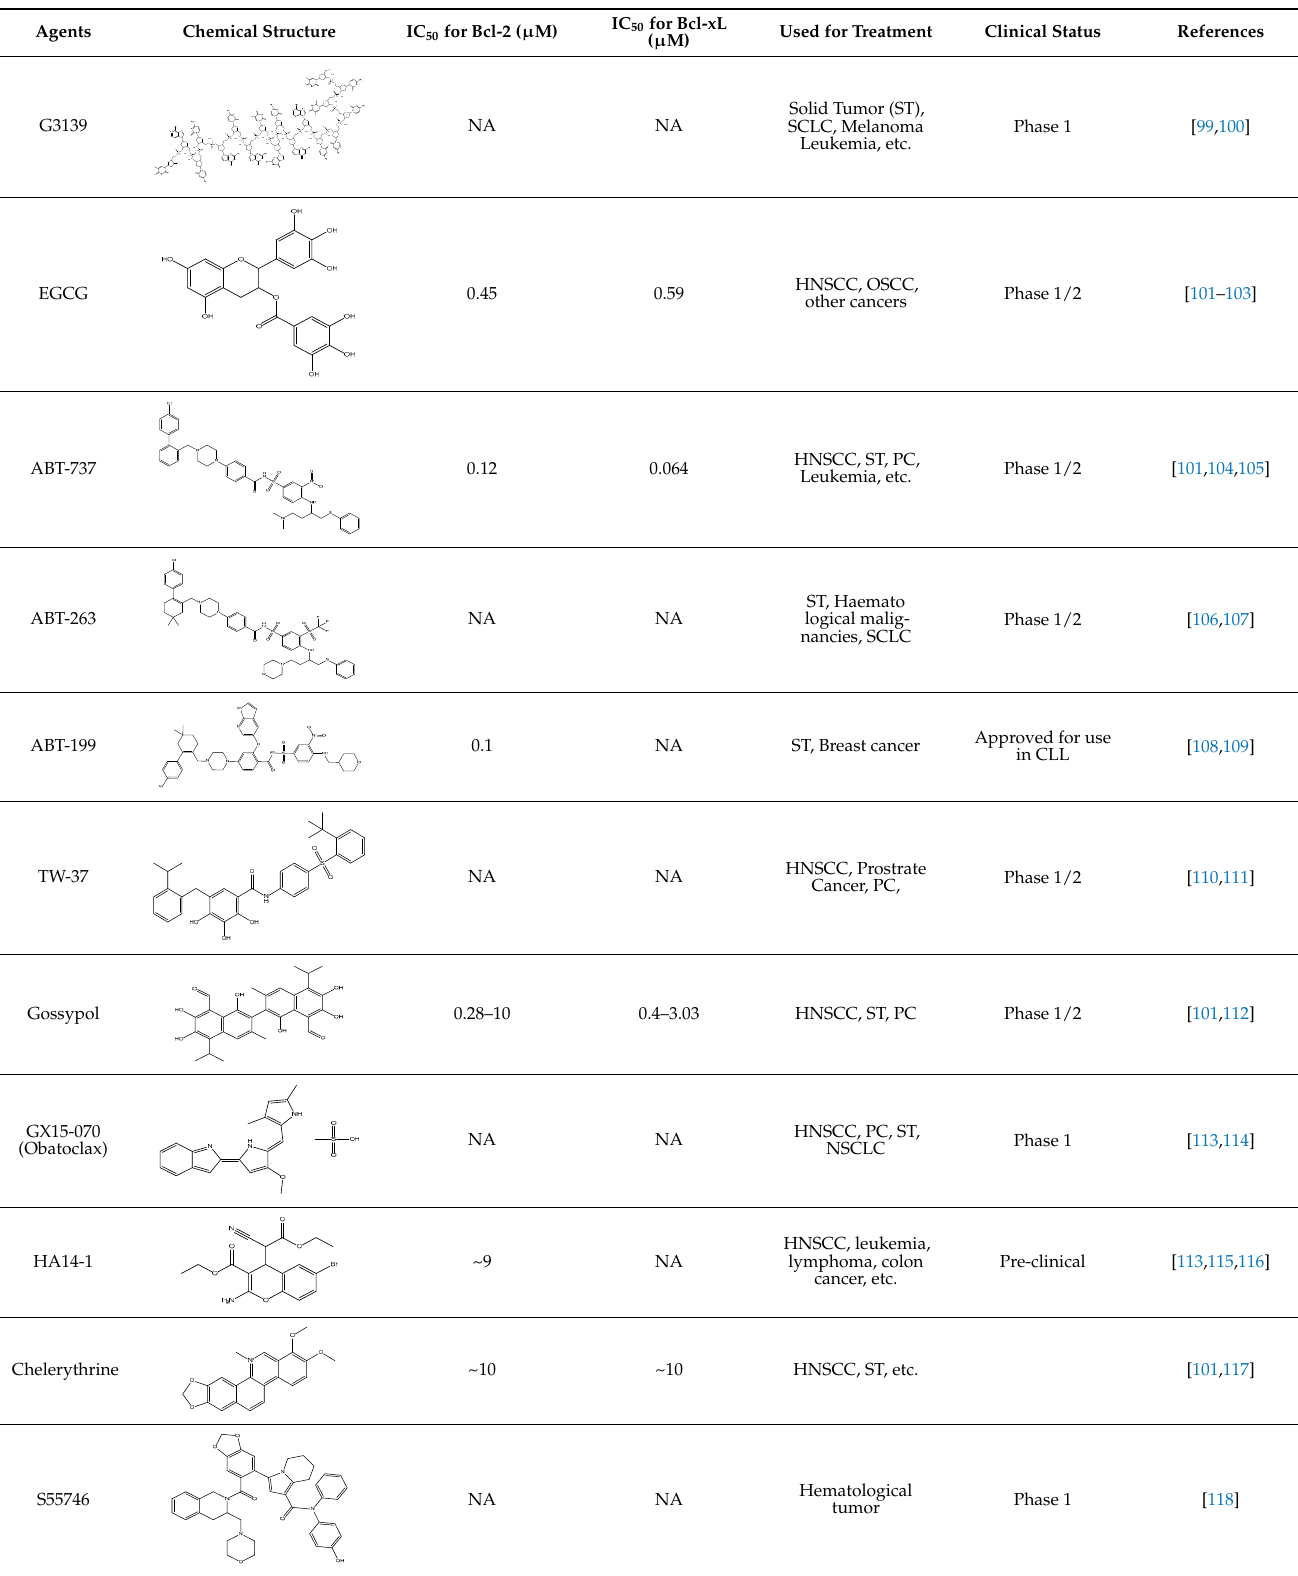
Table 1. Bcl-2 inhibitors are used for the therapeutic targeting of several cancers.